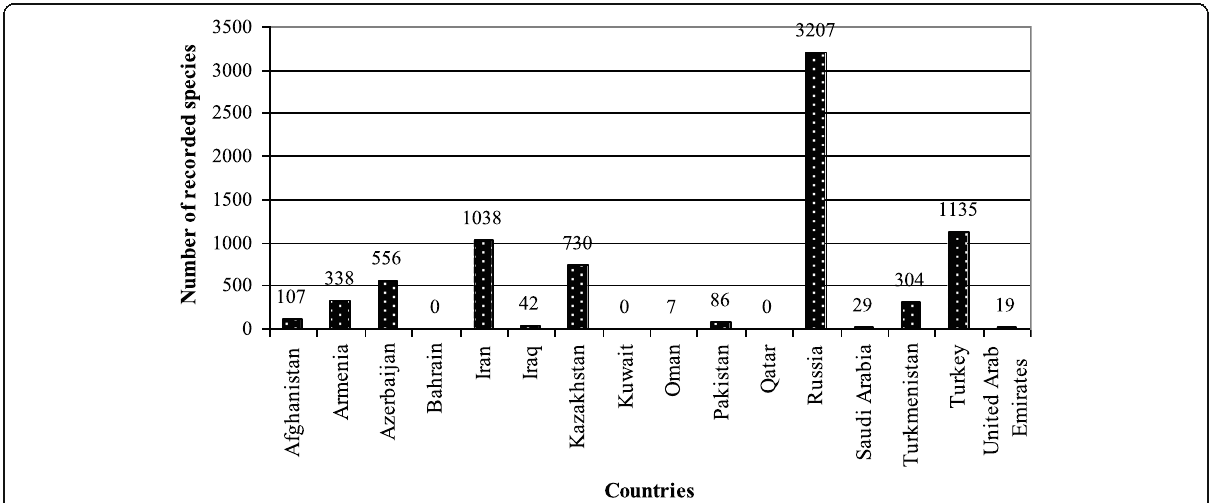
Fig. 3 Comparison of species diversity of Iranian Braconidae to the adjacent countries (based on Yu et al. 2016 for all countries excluding